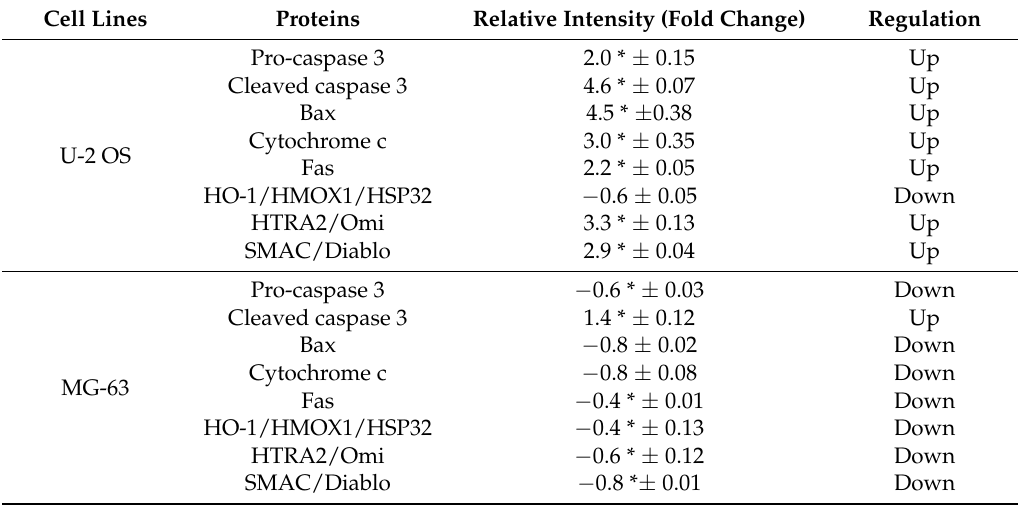
Table 2. Apoptosis pathway-related protein expression in DK1 treated U-2 OS and